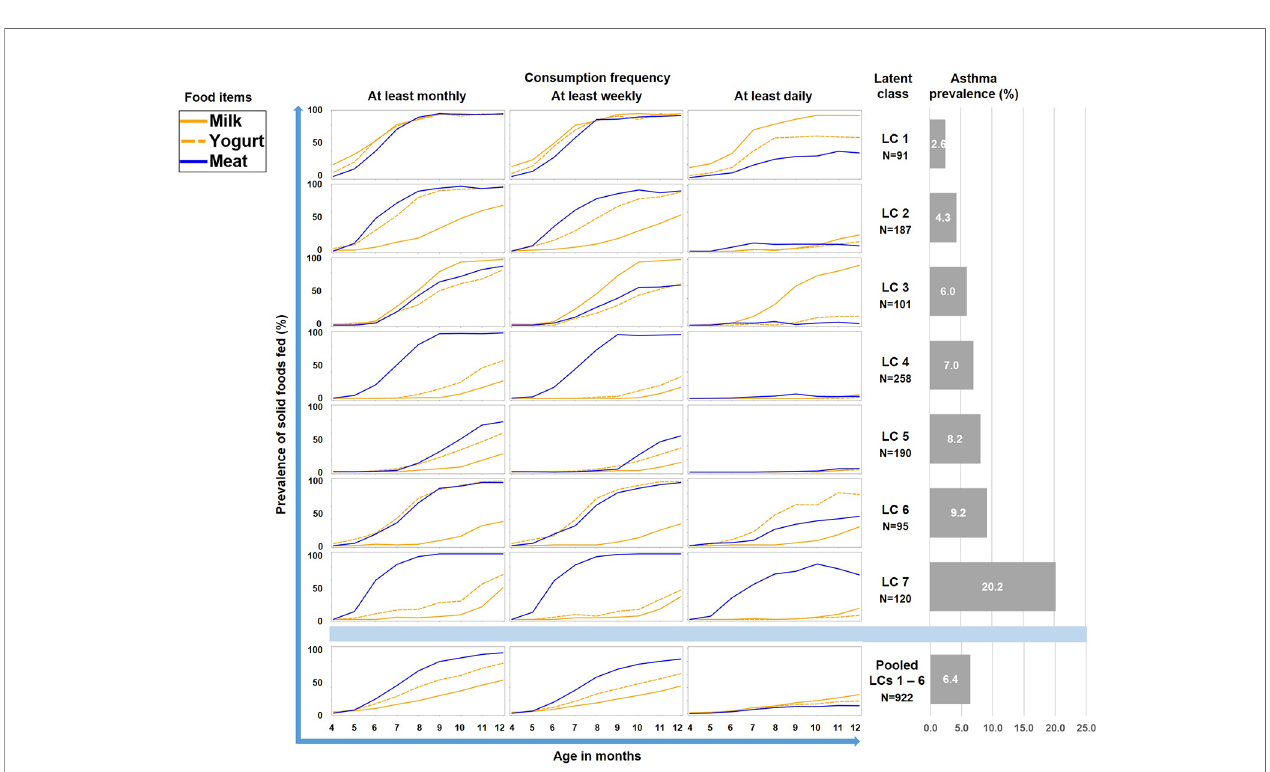
FIGURE 5 | Food introduction styles in PASTURE as de fi ned by a latent class analysis of consumption of meat, milk, and yoghurt over 9 months from month 4 to 12.